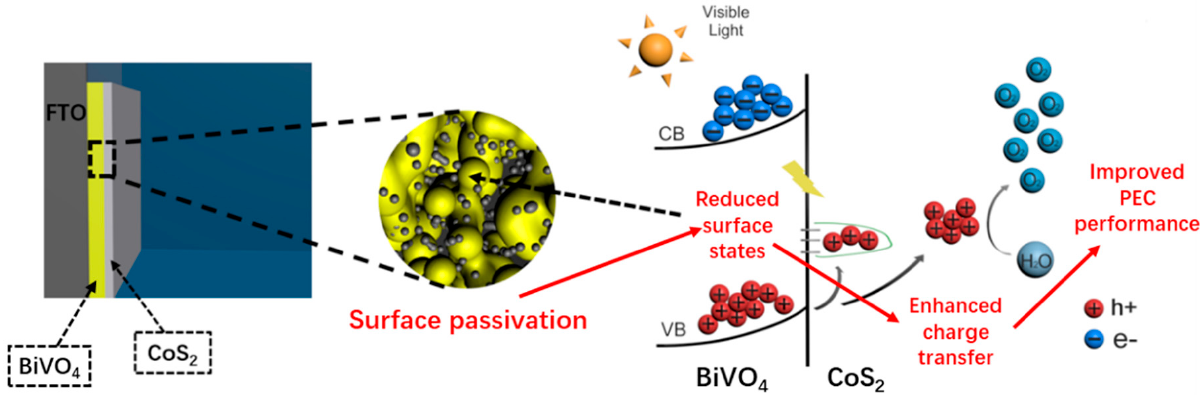
Figure 7. Schematic illustration for the proposed function of CoS 2 to improve the PEC performance of BiVO 4 .